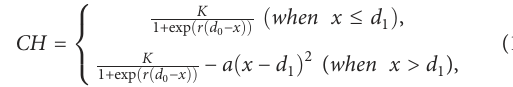
for more than 2 weeks before the measurement. Stem and leaf weight (SLW; g) was obtained as ADW − grain weight (GW; g).